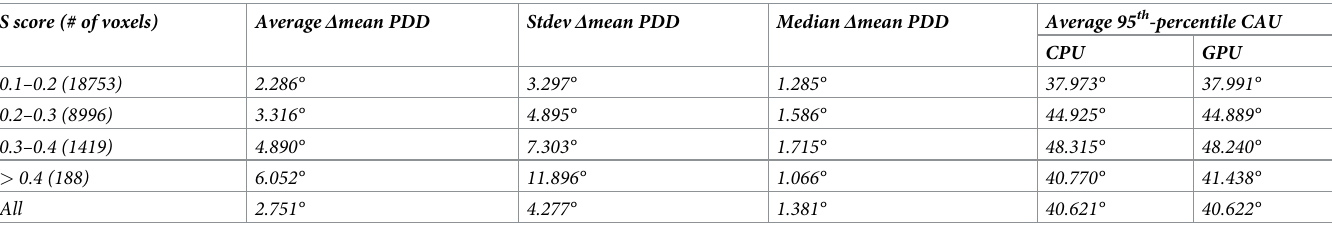
Table 4. Significantly different ϕ 1 , θ 1 in the